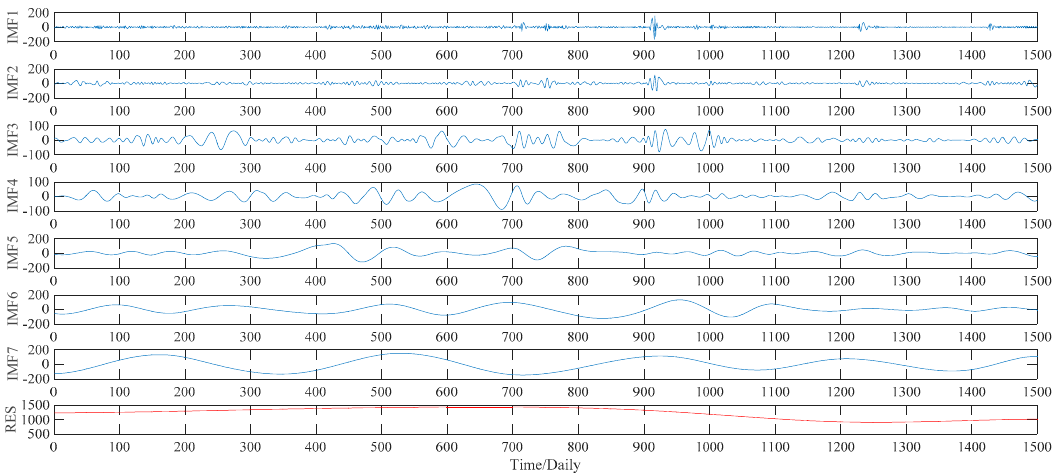
Figure 19. Decomposition results of the EMD method (soybean).